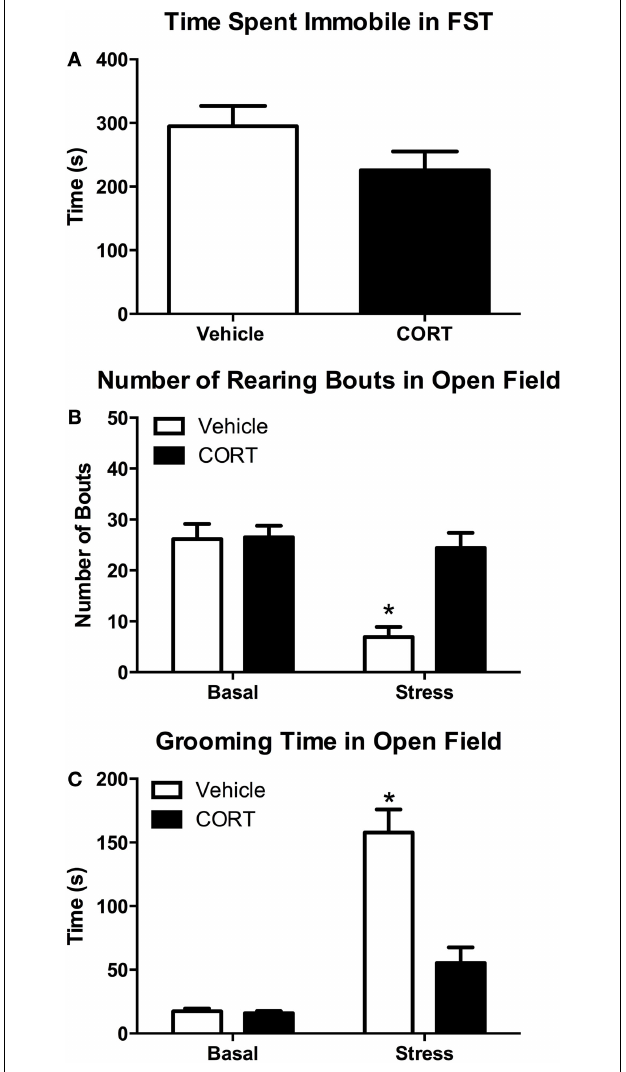
FIGURE 5 | Chronic low-dose CORT does not affect behavior in the FST, but blocks normal stress-induced anxiety behaviors in a novel environment after the FST . Four weeks of CORT (25 µ g/ml) in the drinking water does not alter time spent immobile in the FST (A) . Following the FST, vehicle-treated mice show subsequent anxiety-like behavior in an open field as measured by decreased rearing (B) and increased grooming (C) , while CORT-treated mice are statistically indistinguishable from controls, suggesting they do not show normal stress-induced anxiety-like behavior. Asterisks indicate statistically significant differences at the P < 0.05